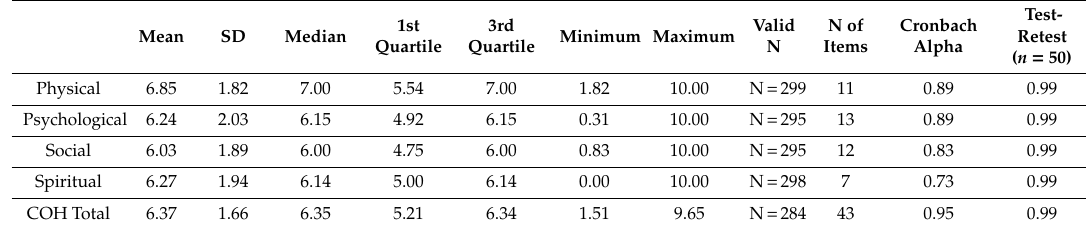
Descriptive indicators for the City of Hope Quality of Life-Ostomy Questionnaire (CoH-QoL-OQ) and subscales, and coe ffi cients supporting very good Cronbach alpha internal consistency coe ffi cient and test-retest